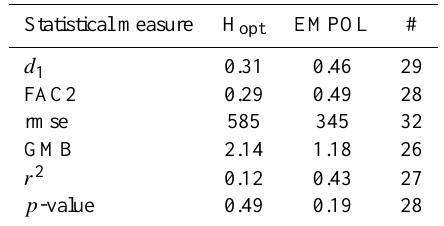
Table 7. Statistical results for the two model configurations based on pollen concentrations. Values are means over all measuring sites. The rmse is given in pollen per cubic meter. Figures in the last column give the number of sites where EMPOL scores better than H opt . The total number is 34